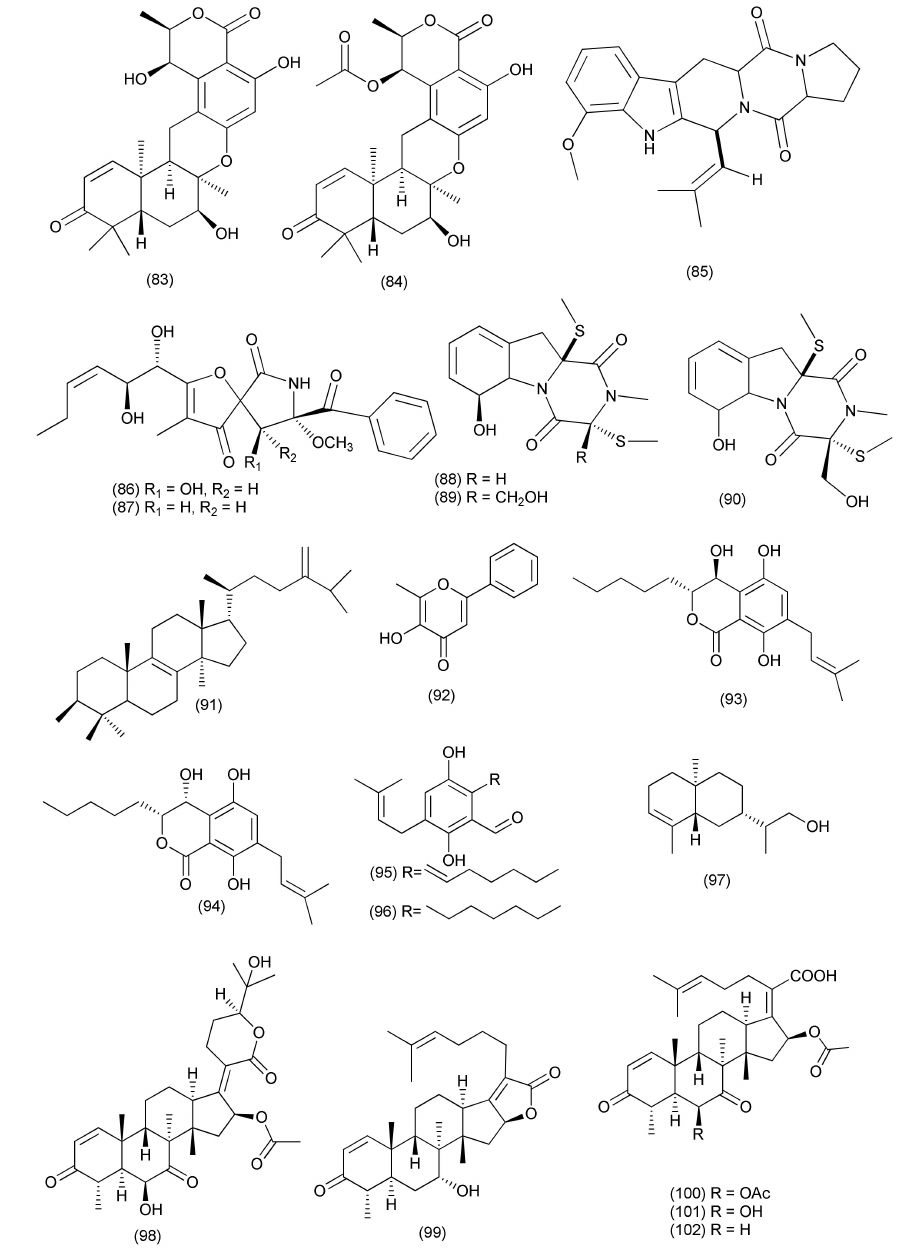
Figure 6. Structures of metabolites 83 – 102 isolated from